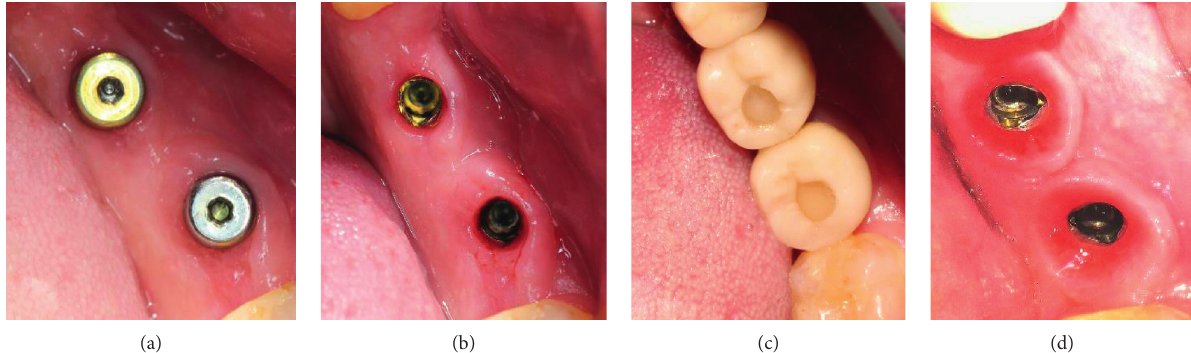
Figure 12: Stages of soft tissue formation: (a) immediately after surgery, (b) after 6 to 8 weeks (with prefabricated gingiva former), (c) after 10 weeks (with provisional crowns), and (d) after 12 weeks of provisional